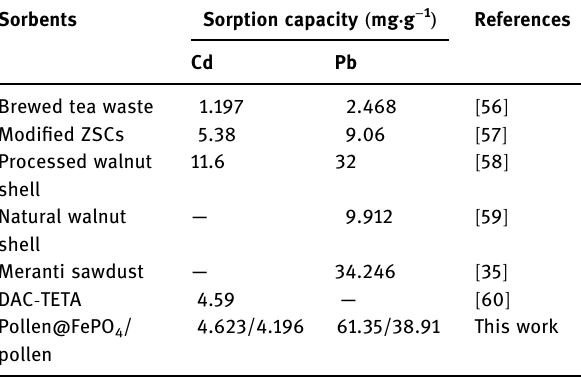
Table 3: Comparison of adsorption capacities of various adsorbents for metal ions